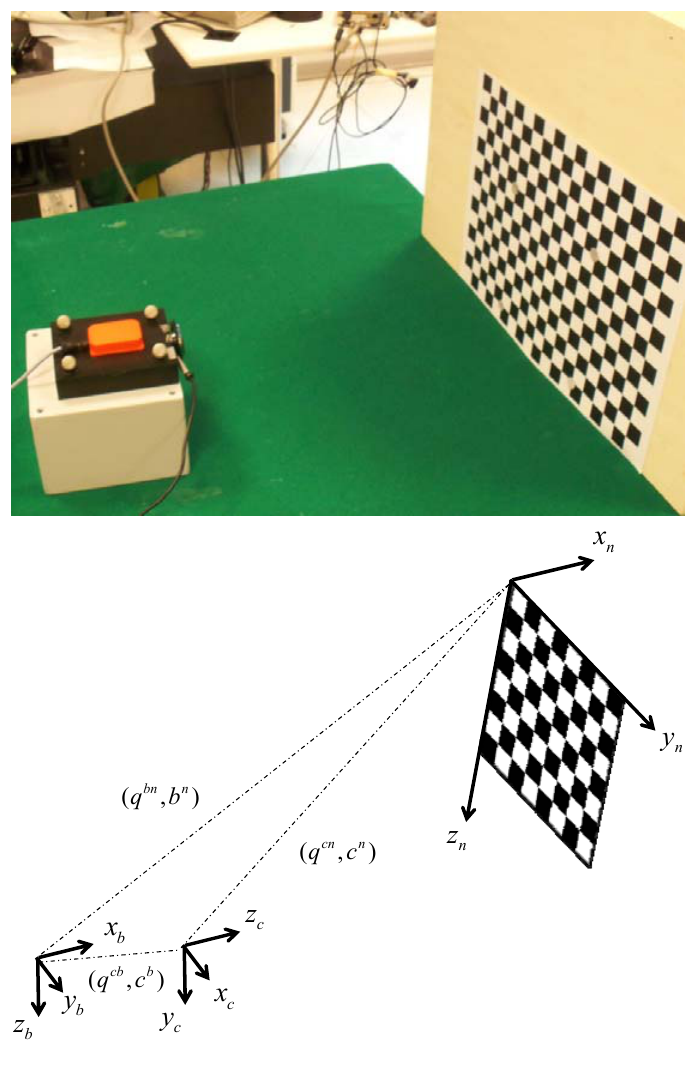
Figure 1. The camera is rigidly attached to the same support where the IMU sensor case is also attached. The axes of the three frames { n }, { c } and { b } are also